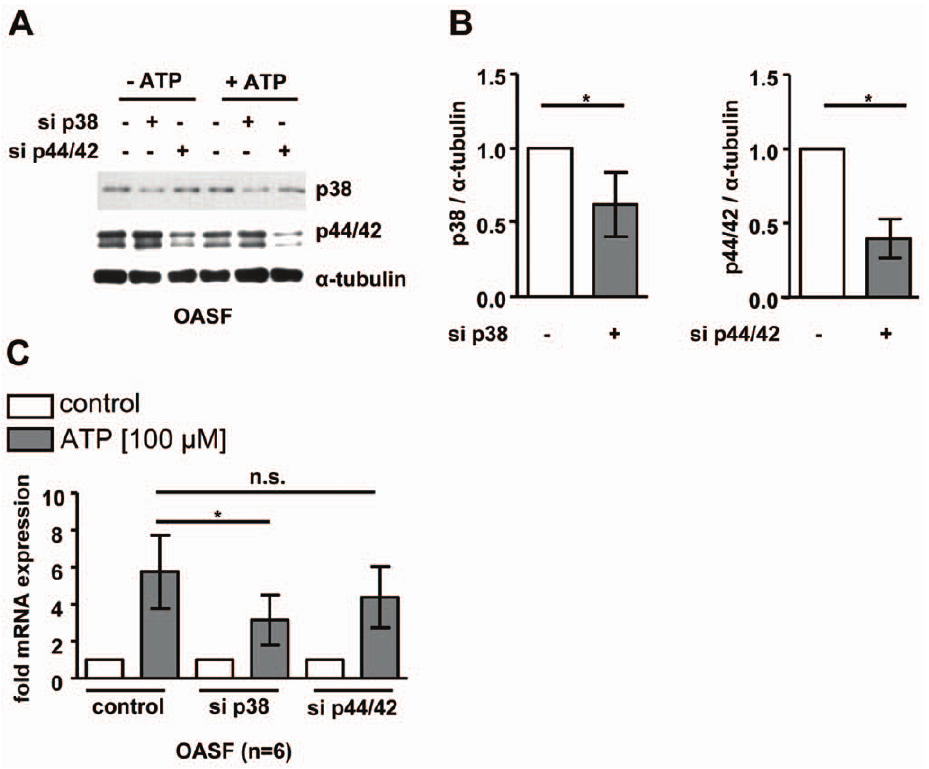
Figure 6. Inhibition of p38 and p44/42 MAPK signaling by siRNA transfection. OASF (n=6) were transfected with siRNA targeting p38 MAPK, p44/42 MAPK and scrambled siRNA (control) before ATP (100 m M) stimulation for 2 h. A . Decreased p38 and p44/42 MAPK expression after siRNA transfection was verified by Western blot analysis. B . Densitometric analysis of Western blot results. C . The ATP-induced BDNF mRNA expression was reduced in p38 MAPK siRNA transfected OASF but not in p44/42 MAPK siRNA transfected cells. Data are shown as means 6 standard deviations . *, p , 0.05.